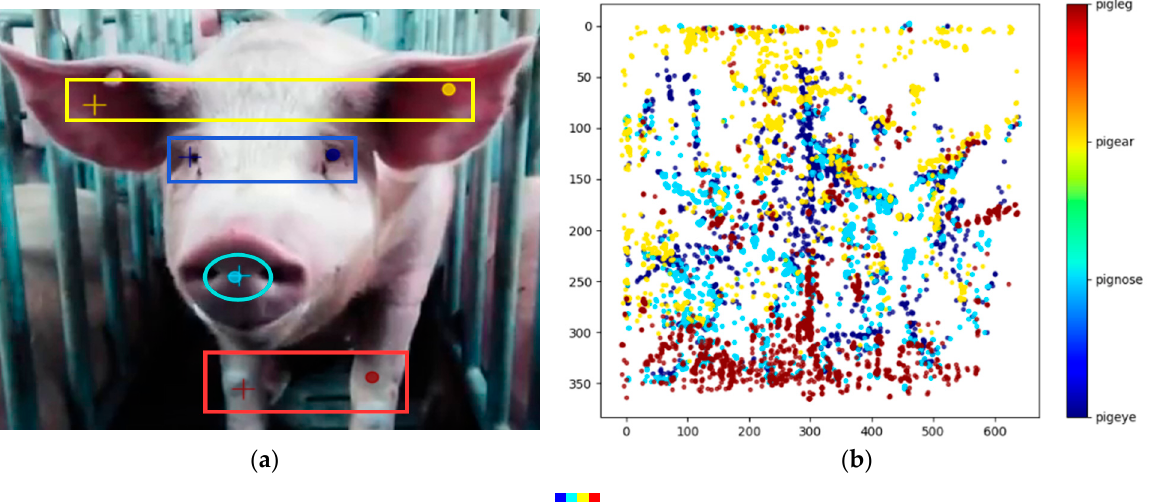
Figure 4. Trajectory tracking error of DLC. ( a ) is marked “++++” to identify the main parts of the piglet, such as its eye, snout, ear, and leg, and the tracking results are marked as “ ”; ( b ) represents the video trajectory tracking results.